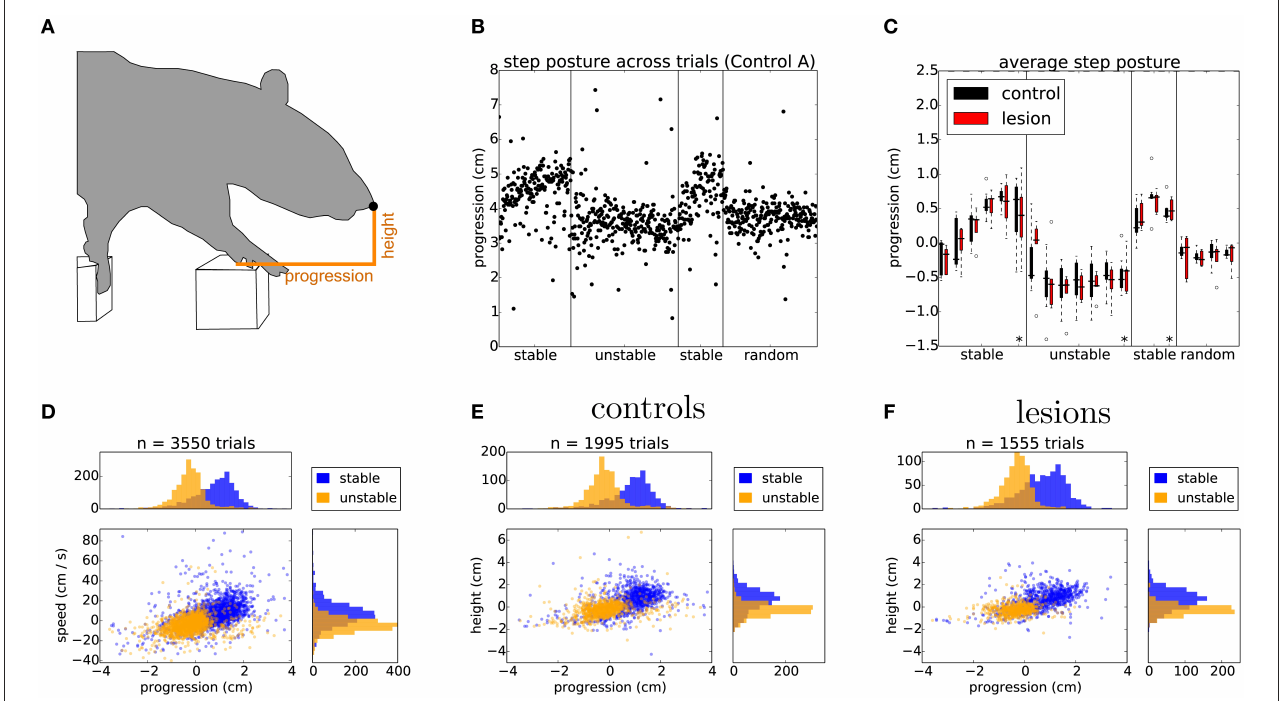
FIGURE6 Rats adapt their postural approach to the obstacles after a change in physics. (A) Schematic of postural analysis image processing. The position of the animal’s nose is extracted whenever the paw activates the ROI of the first manipulated step (see Section 6). (B) The horizontal position, i.e., progression, of the nose in single trials for one of the control animals stepping across the different conditions of the shuttling protocol. (C) Average horizontal position of the nose across the different protocol stages for both lesion and control animals. Asterisks indicate the average nose position on the 20 trials immediately preceding a change in protocol conditions (see text). (D) Distribution of horizontal position against speed for the last 2 days of the stable (blue) and unstable (orange) protocol stages, average nose progression during stable trials (0.77 ± 0.93 cm) and unstable trials (–0.25 ± 0.73 cm). (E, F) Distribution of nose positions for control and lesion animals over the same sessions: average nose height during stable trials (controls: 0.61 ± 1.02 cm, lesions: 0.65 ± 0.91 cm) and unstable trials (controls: –0.25 ± 0.69 cm, lesions: –0.25 ± 0.49 cm), average nose progression during stable trials (controls: 0.84 ± 0.93 cm,